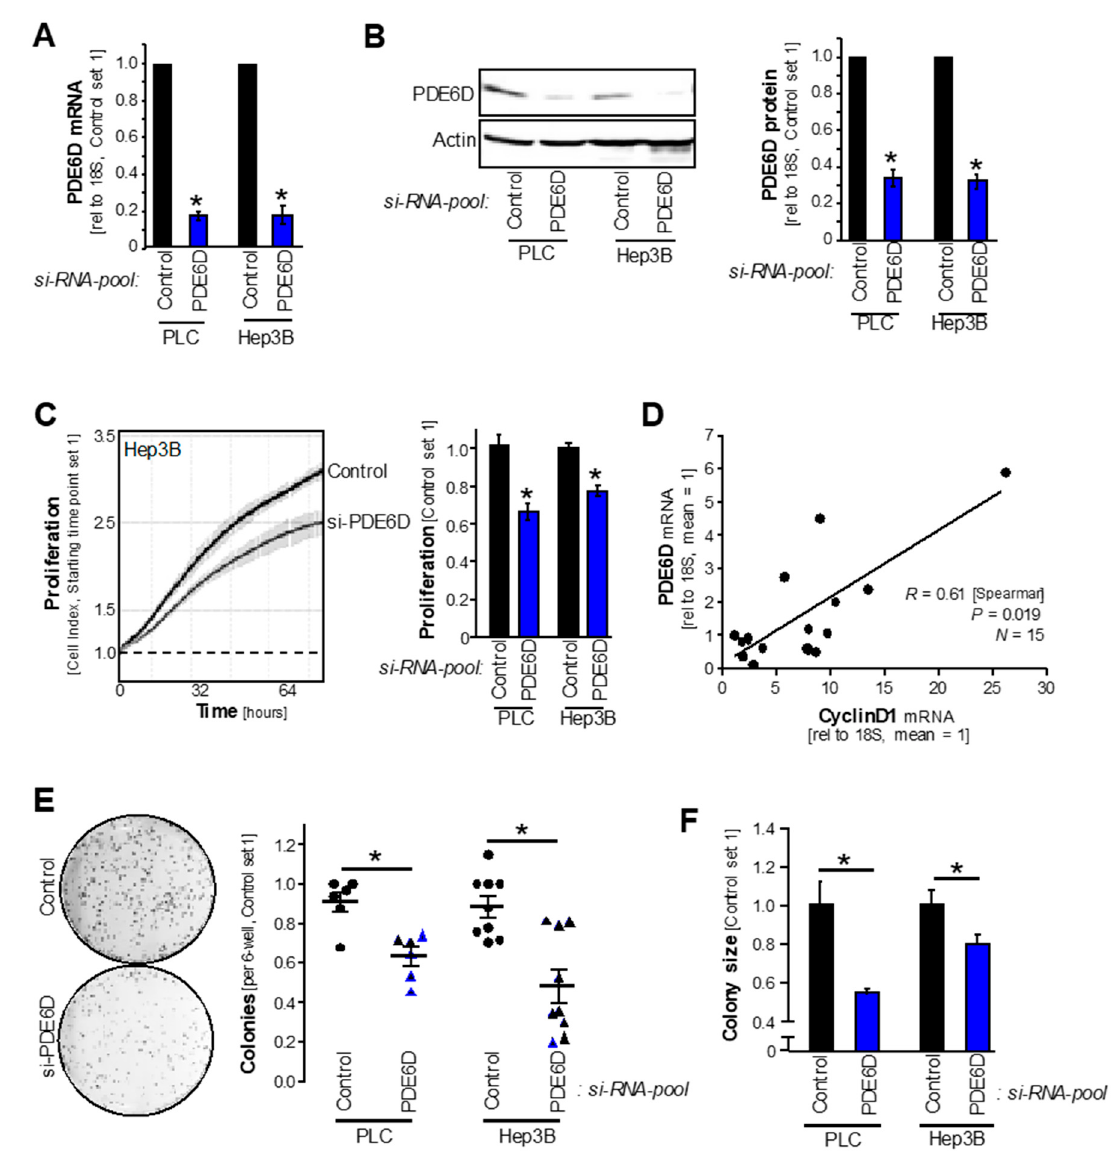
Figure 3. Effects of PDE6D knockdown on HCC proliferation and clonogenicity. Prior to functional experiments, HCC cell lines (PLC, Hep3B) were transfected with si-RNA-pools against PDE6D (“PDE6D”) or the according control- si-RNA-pool (“Control”). ( A ) PDE6D mRNA levels as quantified by qRT-PCR analysis (* p < 0.05 vs. control). ( B ) PDE6D protein levels as quantified by Western blot analysis. The left panel depicts an exemplary Western blot image, and the right panel depicts the summarized densitometric quantification (* p < 0.05 vs. control). ( C ) Real-time cell proliferation (xCELLigence). Exemplary proliferation curves (left panel) and quantified “slopes” (summarizing the proliferative ability) (right panel) are shown (* p < 0.05 vs. control). ( D ) Relative (to mean) PDE6D as correlated to CyclinD1 mRNA expression levels (qRT-PCR) in human HCC patient tissue samples. ( E , F ) Anchorage-dependent clonogenic assay (an exemplary image (Hep3B) is depicted in the left panel of ( E )). Quantification of colony number (right panel of ( E )) and sizes ( F ) (* p < 0.05).